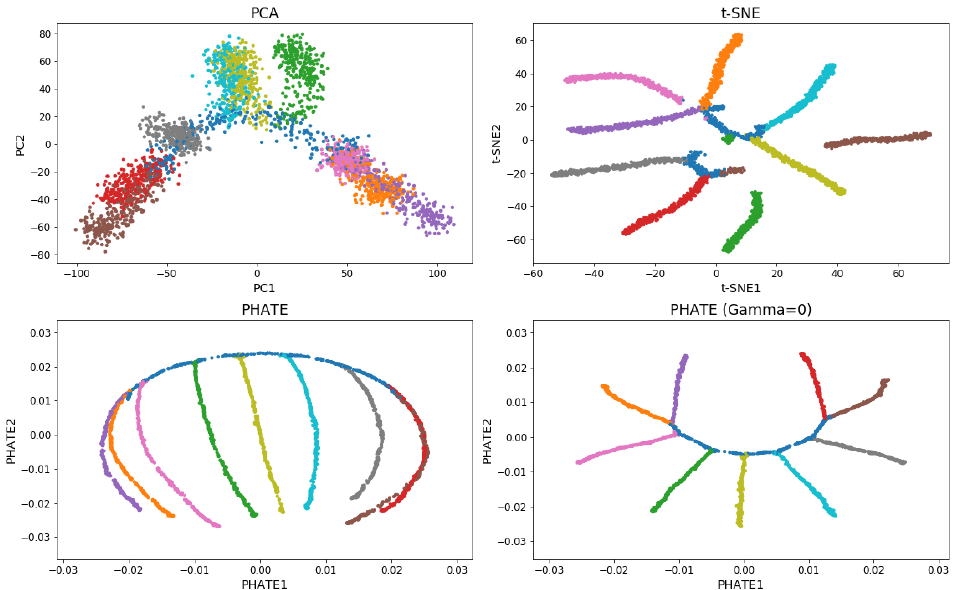
Figure E.2. Comparison of principle component analysis (PCA), t-distributed stochastic neighbor embedding (t-SNE), and potential of heat-diffusion for affinity-based transition embedding (PHATE). Two versions of PHATE with dif- ferent tuning parameters are illustrated. The data are 3000 tree-structured observations with 10 branches. Various branches are colored differently. Note that for this truly trajectory-based data, PHATE gives the clearest low-dimensional representation of the